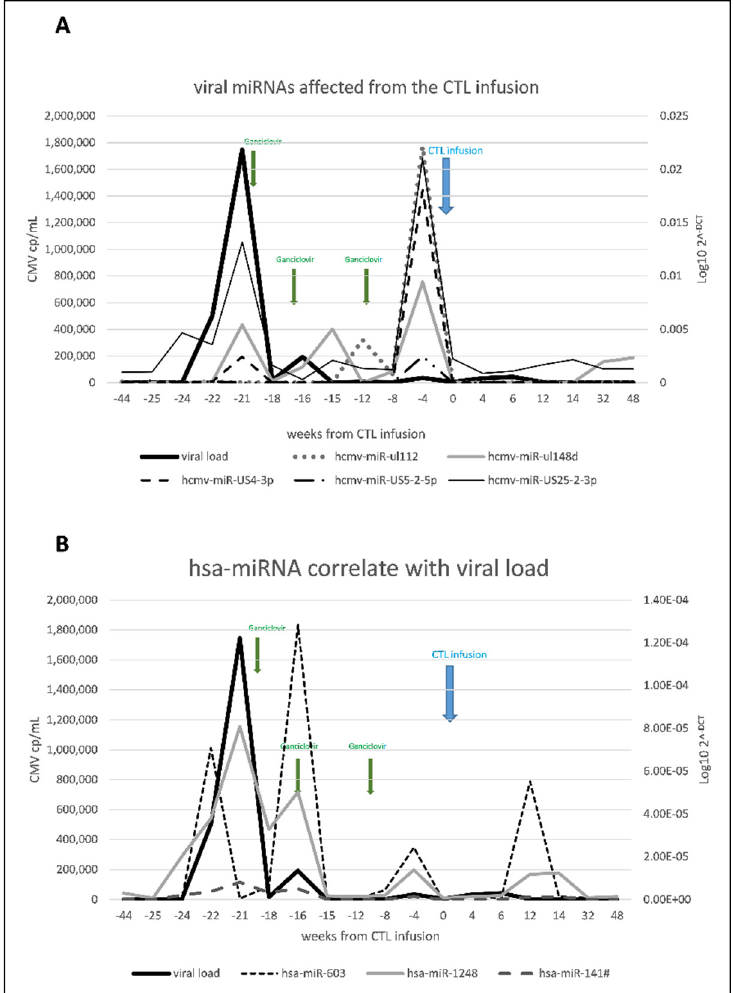
Figure 4. ( A ) Time-course of CMV DNA viral load and the expression profiles of CMV miRNAs, hcmv-miR-ul112, hcmv-miR-ul148d, hcmv-miR-US4-3p, hcmv-miR-US5-2-5p and hcmv-miR-US25- 2-3p in relation with the CMV-reactive T-Lymphocyte infusion. Green arrows indicate Ganciclovir (GCV) administration, and the blue arrow indicates the CMV-reactive T-cells infusion. ( B ) Time- course of CMV DNA viral load and the expression profiles of host cellular miRNAs, hsa-miR-603, hsa-miR-1248 and hsa-miR-141#, in relation with the CMV-reactive T-Lymphocyte infusion. Green arrows indicate GCV administration, and the blue arrow indicates the CMV-reactive T-cells